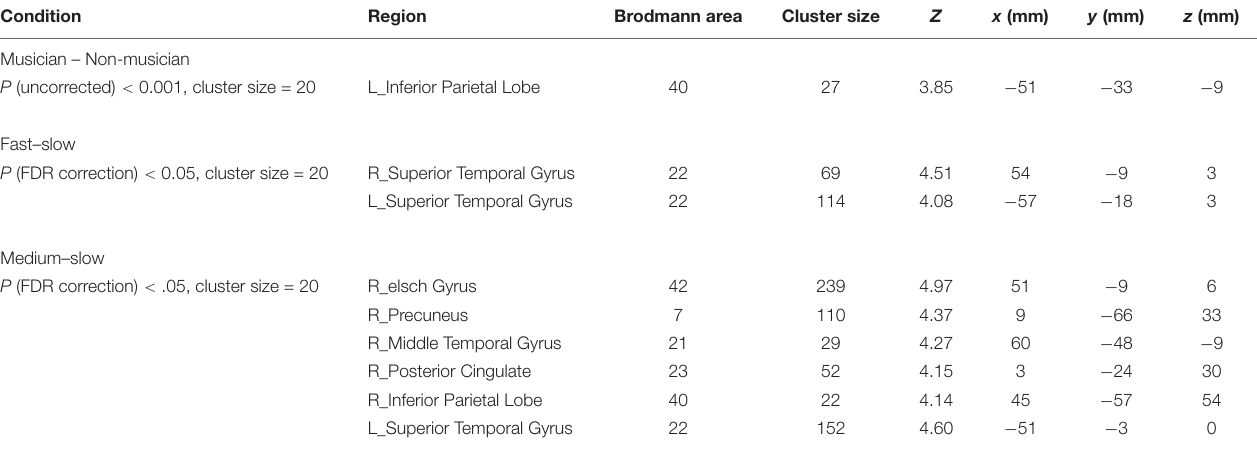
TABLE 2 | fMRI analysis of difference between musicians and non-musicians and difference among fast-, medium-, and slow-tempo music.